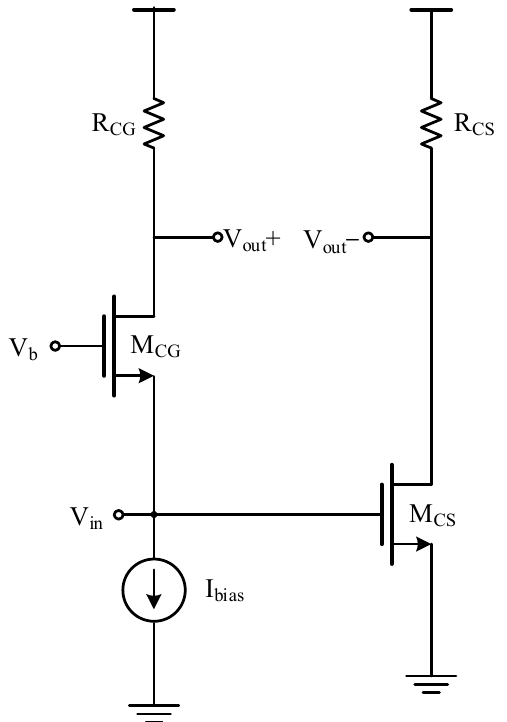
Figure 1. CG-CS active-balun LNA.